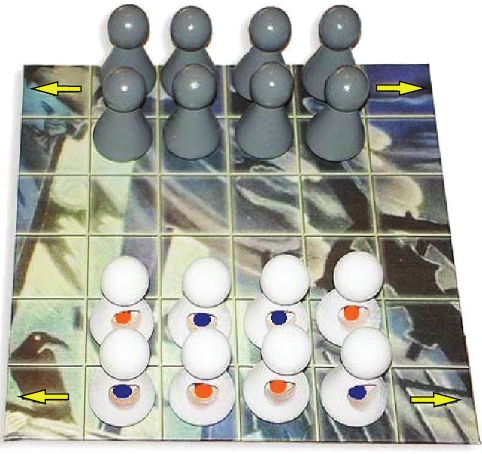
Figure 1: Initial setup of Ghosts .